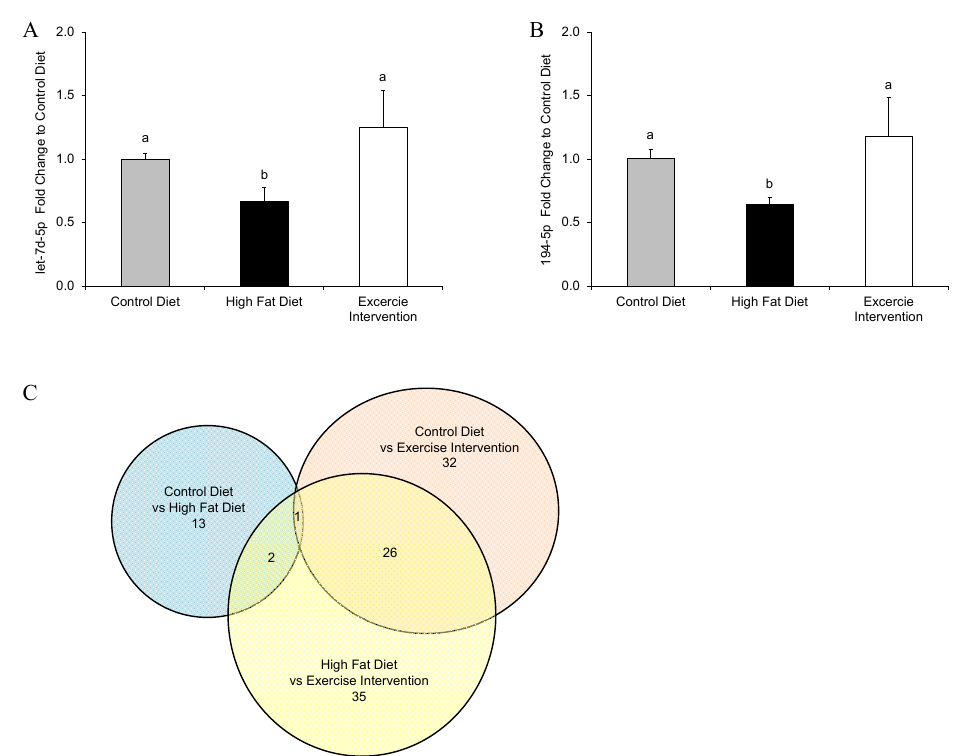
Figure 5. The effect of a paternal high fat diet with exercise interventions on the expression of pancreatic microRNAs in male offspring. The expression of microRNA ( A ) let7d-5p and ( B ) 194-5p in the pancreases of male offspring was reduced by a paternal HFD and restored by an exercise intervention to an abundance that was not different to that of offspring sired by CC-fed fathers; ( C ) the number of differentially expressed microRNAs between groups and the number of differential microRNAs in common between groups. Data is presented as mean fold change ± standard error mean by ∆∆ C t ( A , B ) or number of microRNAs ( C ). n = 4 male offspring; representative of n = 4 fathers per group. a, b Different letters denote significant difference at p < 0.05. Table 4. The top five ranked molecular networks identified by Ingenuity pathway analysis of microRNA